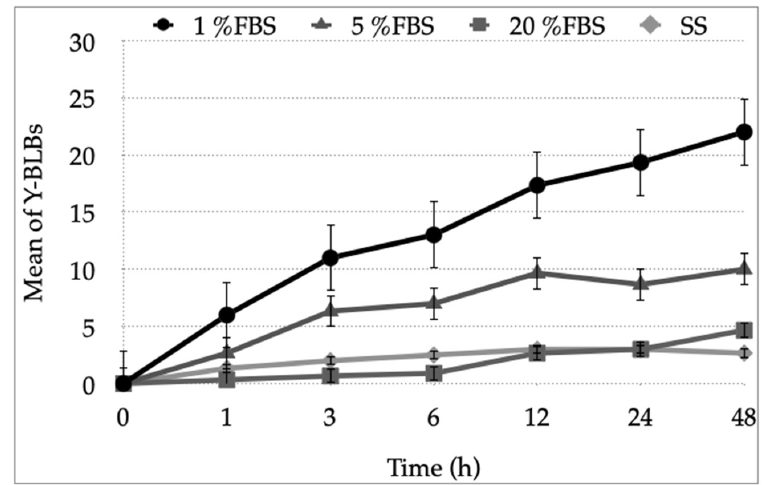
Figure 7. Means of Y-BLBs were obtained for all bacterial strain and yeast strain combinations cultured in BB supplemented with 1%, 5% or 20% FBS or SS during 48 h. This figure shows the means of Y-BLBs obtained when co-culturing H. pylori J99 and C. glabrata ATCC 90030 strains. The higher means of Y-BLBs for this bacteria–yeast combination were observed at 24 h and 48 h. Culture medium supplemented with 1% or 5% FBS produced the higher means of yeast cells harboring